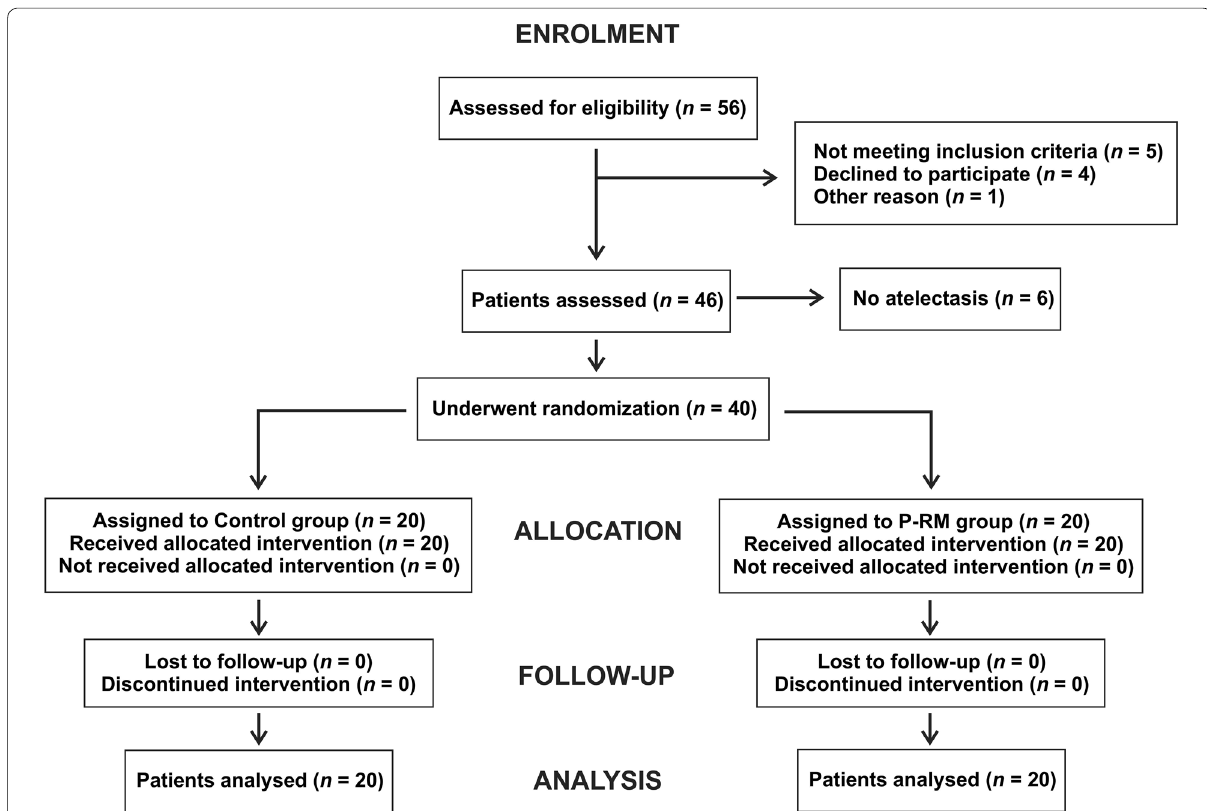
Fig. 2 The CONSORT flow